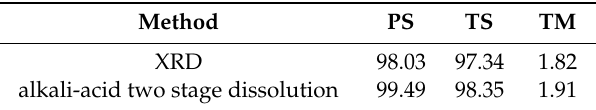
Table 3. Comparison of glass phase content in slag